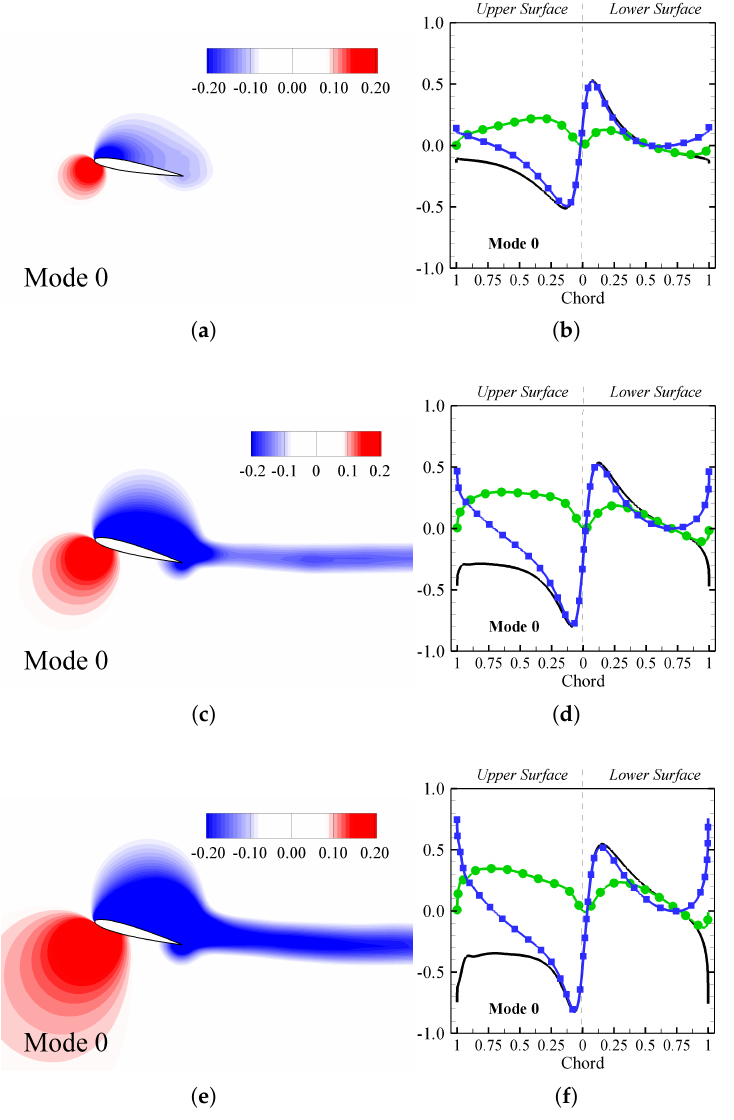
Figure 11. ( a , c , e ) Mean pressure modes ¯ p , ( b , d , f ) Surface modes ¯ p s ( ), along with dissection into − ¯ p s sin Γ ( ) and − ¯ p s cos Γ ( ) : AOA = 10 ◦ , 15 ◦ , and 20 ◦ , top to